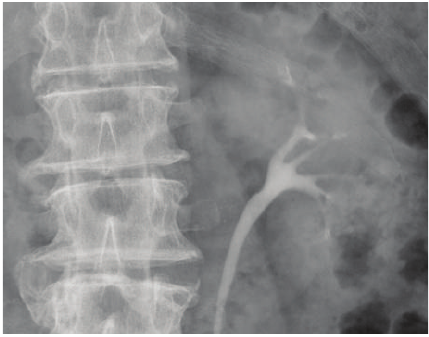
Figure 2: Intravenous urogram demonstrates a filling defect in the lower pole calyx of the left kidney, a histologically-proven urothelial cell